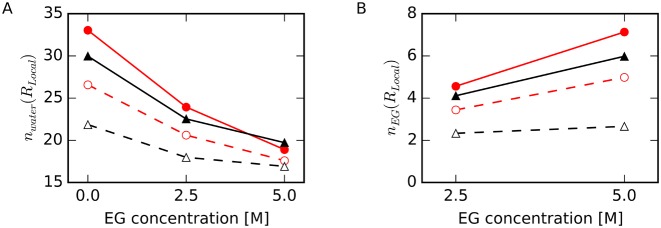
(A) Number of water molecules, nwater(RLocal), and (B) number of EG molecules, nEG(RLocal), for HP-backbone (filled red circles with solid lines), TBA-backbone (filled black triangles with solid lines), HP-base (open red circles with dashed lines) and TBA-base (open black triangles with dashed lines).